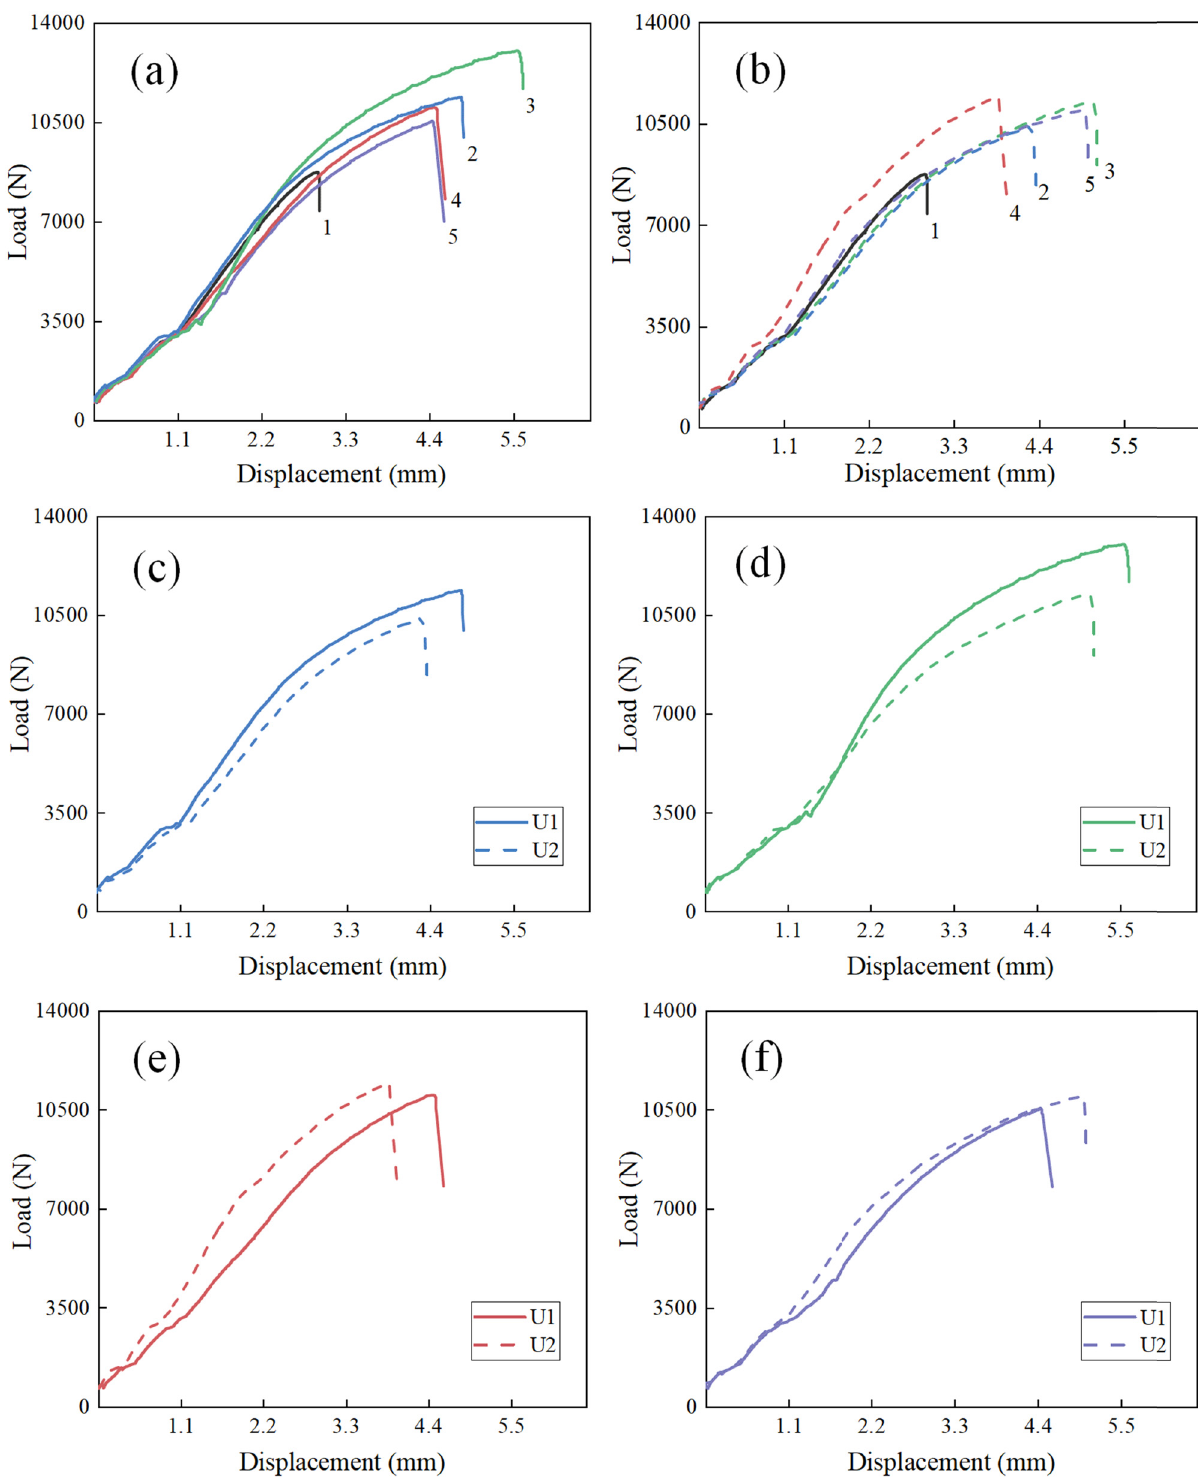
Figure 5: Tensile curves: ( a ) U 0 and U 1 ; ( b ) U 0 and U 2 ; ( c ) Group 2, U 1 and U 2 ; ( d ) Group 3, U 1 and U 2 ; ( e ) Group 4, U 1 and U 2 ; and ( f ) Group 5, U 1 and U 2